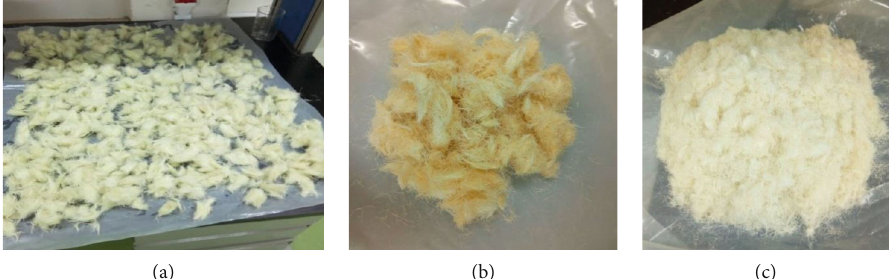
Figure 1: Sisal fi ber (a) treated with NaOH, (b) treated with NaOH and neutralized with acetic acid, and (c) treated with NaOH and neutralized with acetic and bleached by H